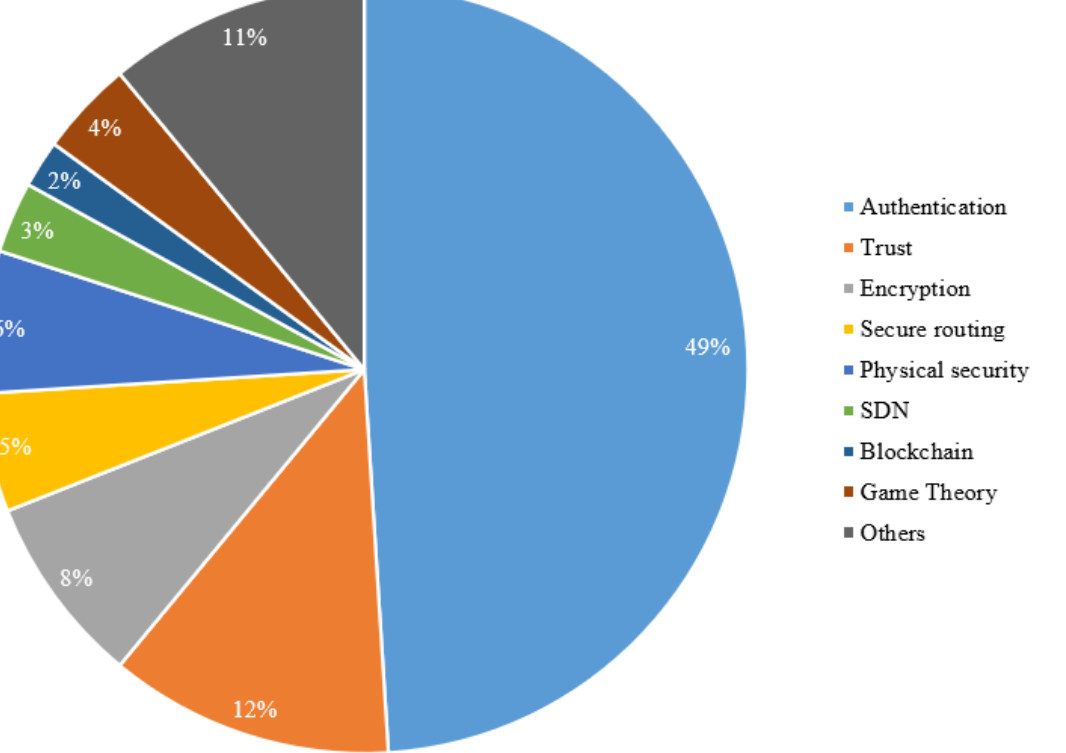
Figure 3. IoT security publications (2016–June 2018) in Elsevier, IEEE, Hindawi and Springer